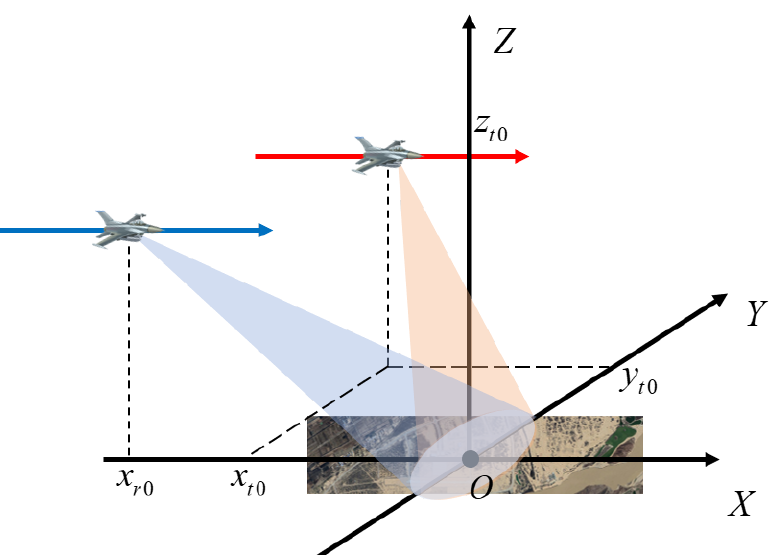
Figure 14. Airborne bistatic forward-looking SAR